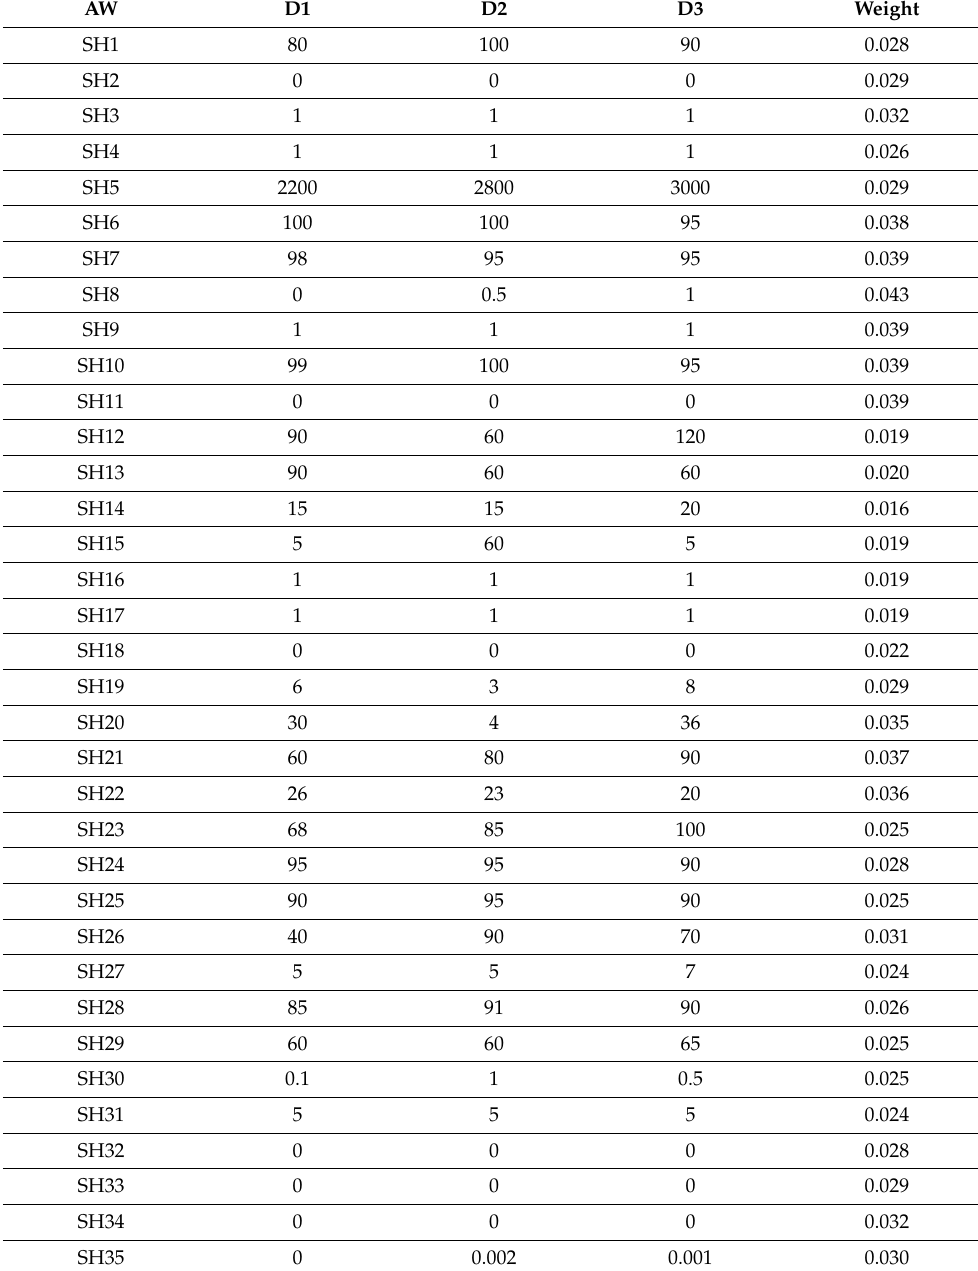
Table 13. Initial CoCoSo decision matrix M .